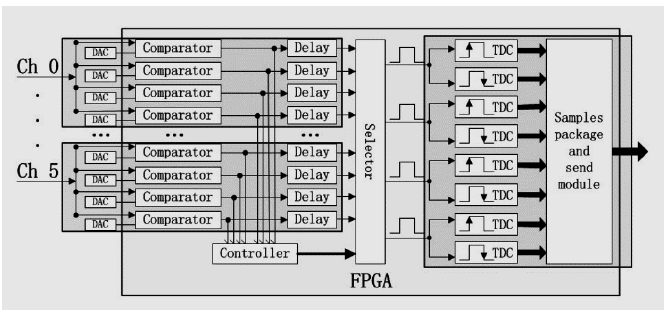
Figure 3. The P&I sensor system. Schematics of the digital readout electronics based on the MVT concept.